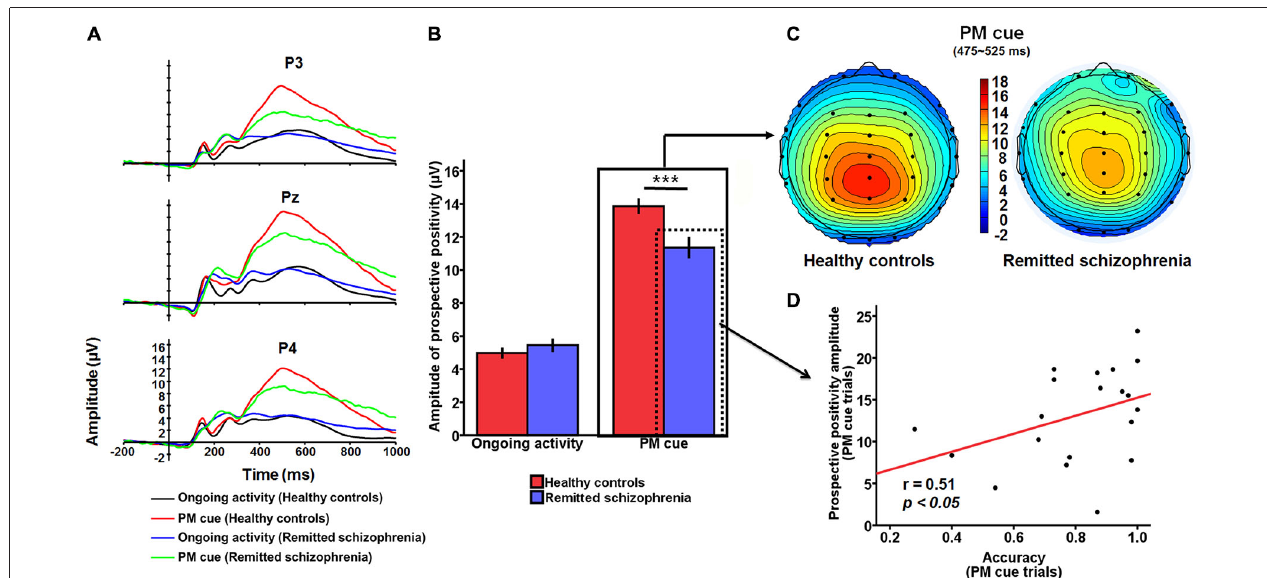
FIGURE 3 | The prospective positivity related to PM intention retrieval. (A) The prospective positivity over the parietal region (P3/Pz/P4) for PM cue trials and ongoing activity trials in symptomatically remitted patients with schizophrenia and healthy controls. (B) Bar plots illustrating the group × task type interaction effect on the amplitude of the prospective positivity over the parietal region. As illustrated in the figure, this interaction effect is driven by the reduced amplitude of prospective positivity elicited by PM cues in symptomatically remitted patients with schizophrenia compared with healthy controls. Error bars indicate SEM, ∗∗∗ p < 0.001. (C) Topographical voltage distributions within 475–525 ms centered on the peak of prospective positivity elicited by PM cue for healthy controls (left) and symptomatically remitted patients with schizophrenia (right). Positive isopotential lines are in red and negative isopotential lines are in blue. As shown in the figure, there is reduced amplitude of prospective positivity over the parietal region in those patients compared with healthy controls. (D) Correlation between accuracy and amplitude of prospective activity on PM cue trials over the parietal region in remitted patients with schizophrenia. As illustrated in this scatter plot, amplitude of PM cue-elicited prospective amplitude over the parietal region is positively correlated with accuracy for PM cue trials in those patients, ( p <